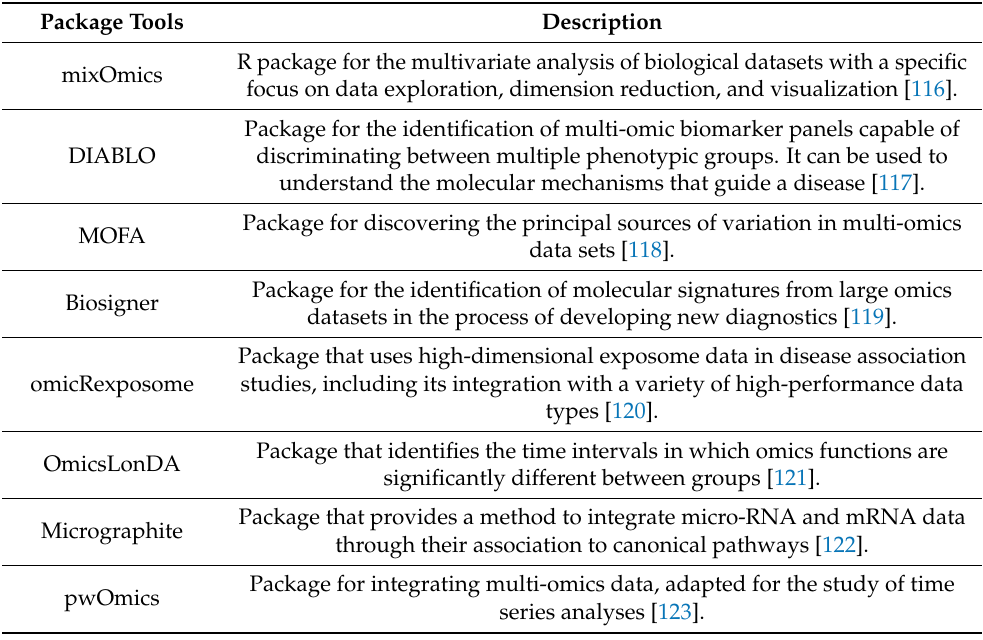
Table 3. Main packages tools implemented in oncology for machine